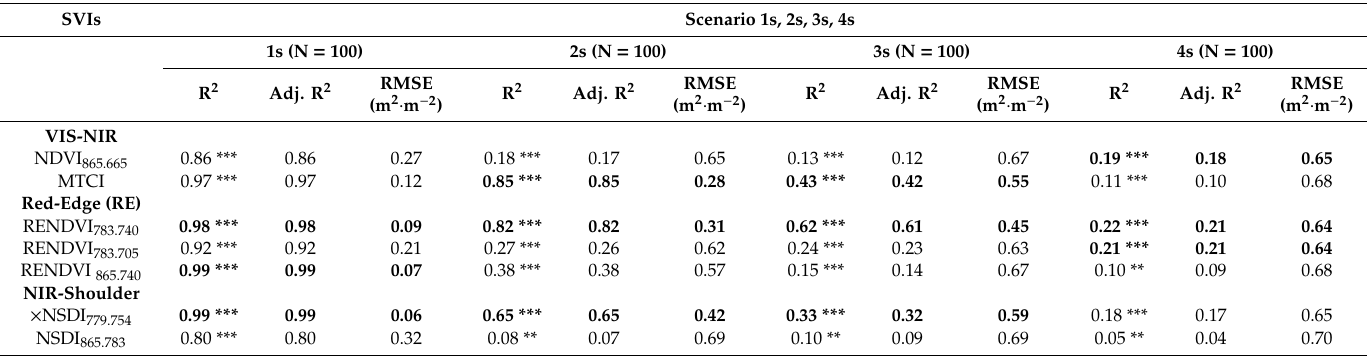
Table 7. Summary of the statistics (N, number of observations; R 2 , coe ffi cient of determination; Adj. R 2 , adjusted coe ffi cient of determination; RMSE, root mean square the spectral vegetation indices (SVIs) calculated from PROSAIL simulated spectra by scenarios considering spatial scale LAI ranges (1t–4t) described in Section 2.3.4. The three best-fitting models are highlighted in bold. Asterisk indicates significance of correlation: *** p < 0.001; ** p < 0.01; * p < 0.05. n.s., not significant (Pearson’s correlation